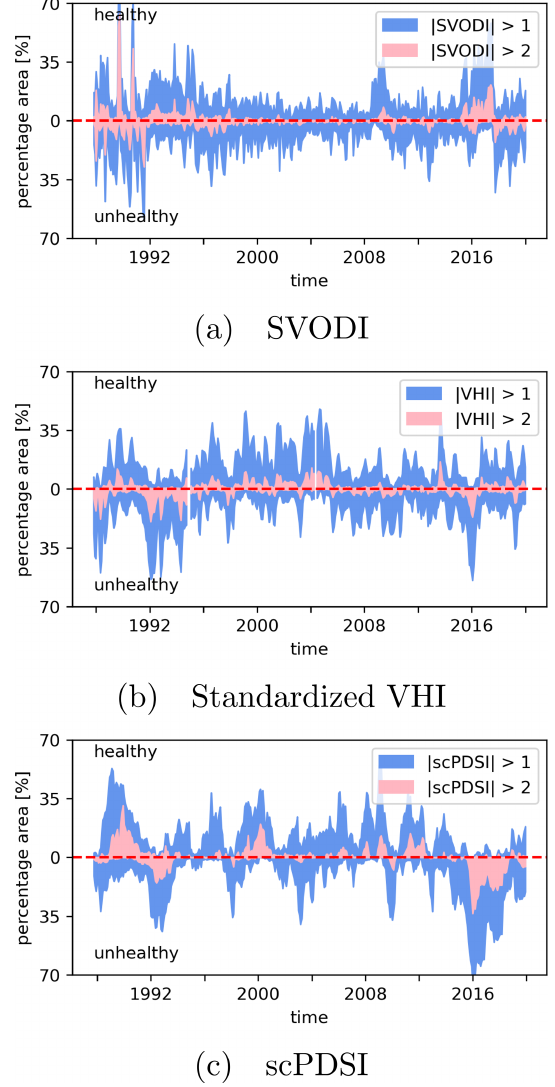
Figure 11. Percentage area of SVODI (a) , standardized VHI (b) and scPDSI (c) greater/smaller than 1/ − 1 and 2/ − 2, respectively, over time for the northern South America AR6 region (Iturbide et al., 2020). All datasets are downsampled to the monthly resolution of